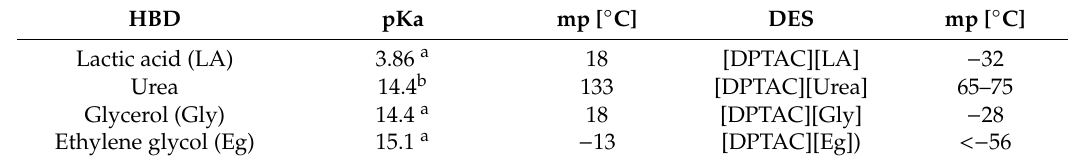
Table 2. Melting points (mp) for the HBDs components of the DESs (the pKa of HBD is also provided). HBD pKa mp [ ◦ C] DES mp [ ◦ C] Lactic acid (LA) 3.86 a 18 [DPTAC][LA] − 32 Urea 14.4 b 133 [DPTAC][Urea] 65–75 Glycerol (Gly) 14.4 a 18 [DPTAC][Gly] − 28 Ethylene glycol (Eg) 15.1 a −